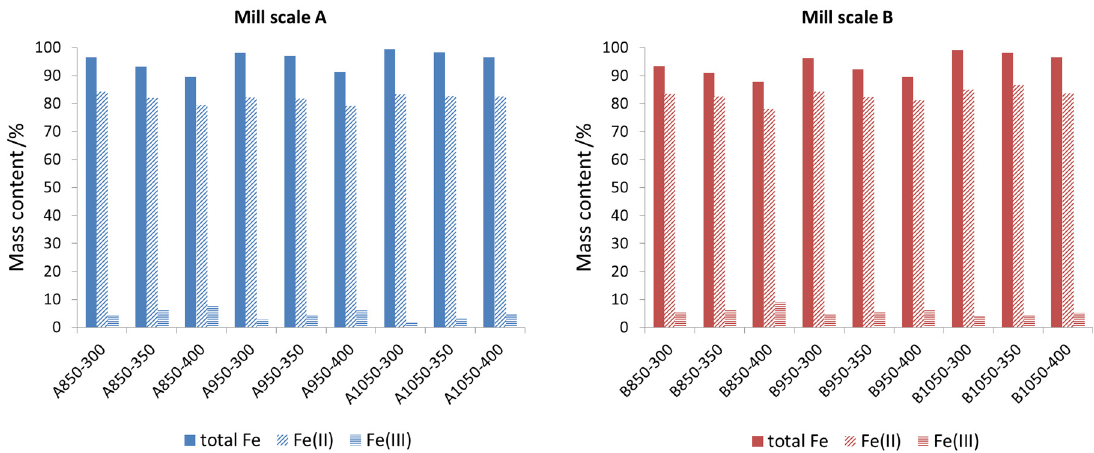
Figure 10. Summary of chemical composition analysis results of mill scale (fractions A and B) subjected to reduction and secondary oxidation process.